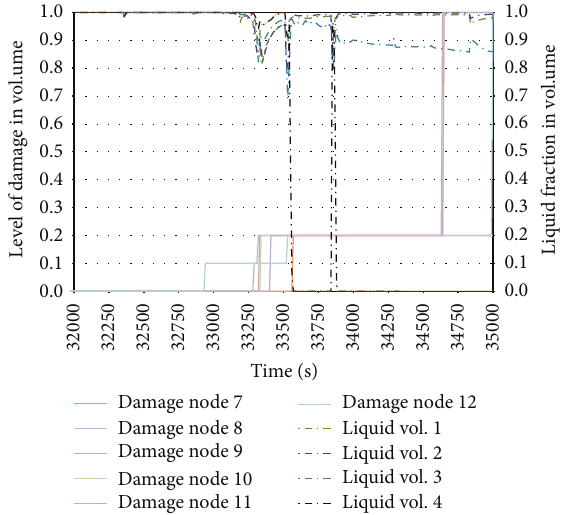
Figure 12: Axial nodes of f2 forming a molten pool in core and fraction of liquid in volumes below the core.